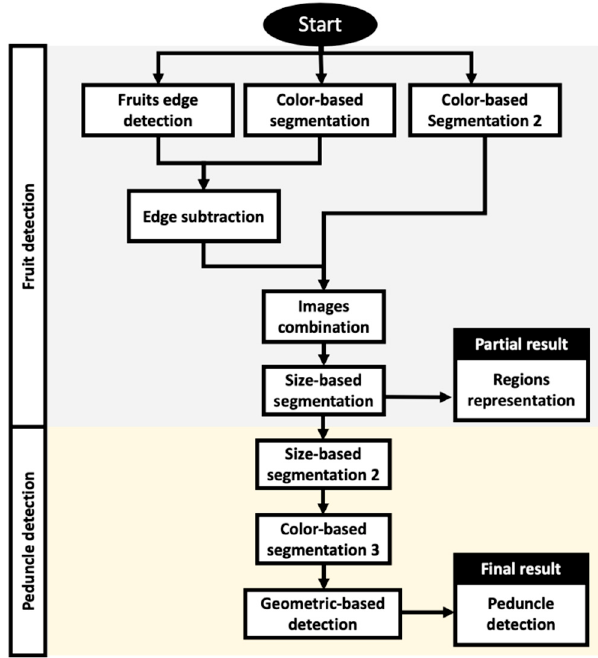
Figure 5. Flowchart of the ripe tomato detection stage.